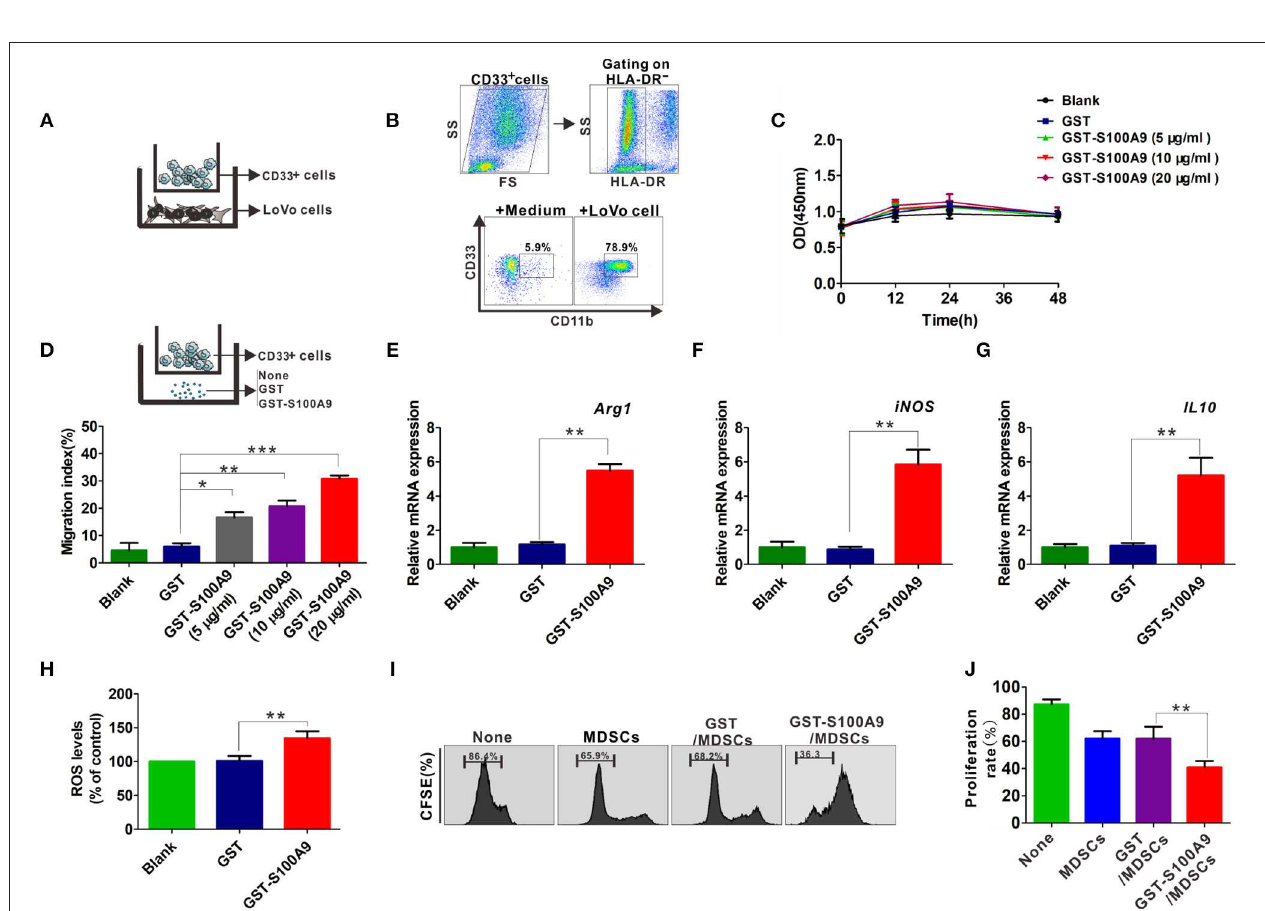
Frontiers in Immunology |